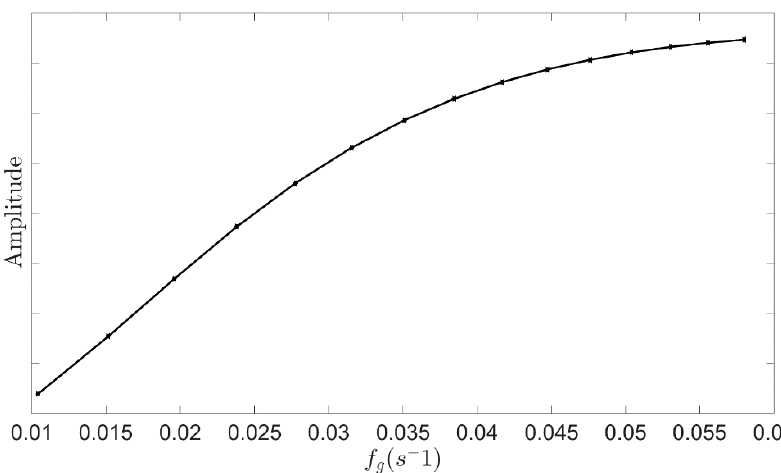
Figure 4. Variation in total infragravity wave amplitude at a fixed position on the virtual slope for wave groups of different frequency using the conceptual model of bound and free wave superposition illustrated in Figure 3. Wave groups have the same group velocity but varying frequency.